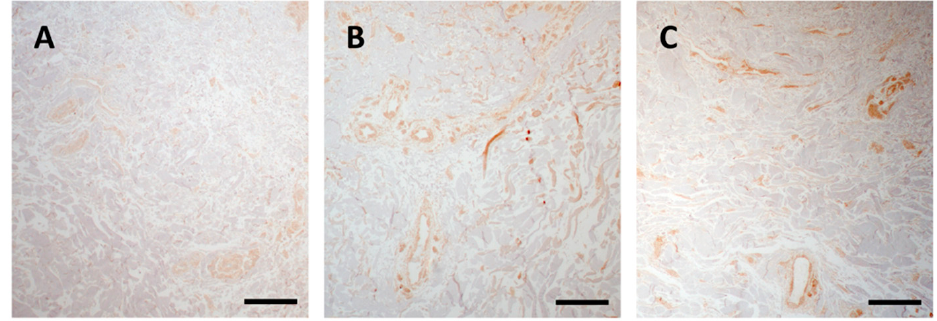
Figure 6. Representative images of immunohistochemistry for p-SMAD2/3 in skin samples obtained from the control subject ( A ) and from clinically unaffected ( B ) and affected ( C ) area in the same PXE patient. Scale bar = 50 µm.